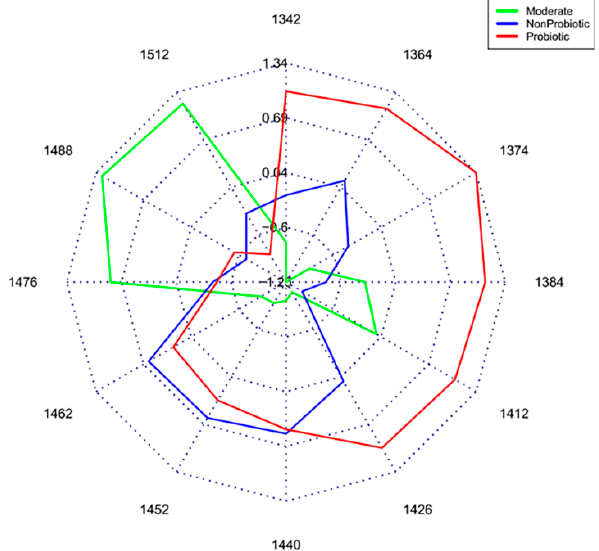
Figure 1. Water spectral pattern presented on aquagrams shows different water structure in different bacteria strains (Reprinted with permission from Slavchev, A., Kovacs, Z., Koshiba, H., Nagai, A., Bázár, G., Krastanov, A., Kubota, Y. and Tsenkova, R. 2015. [22])